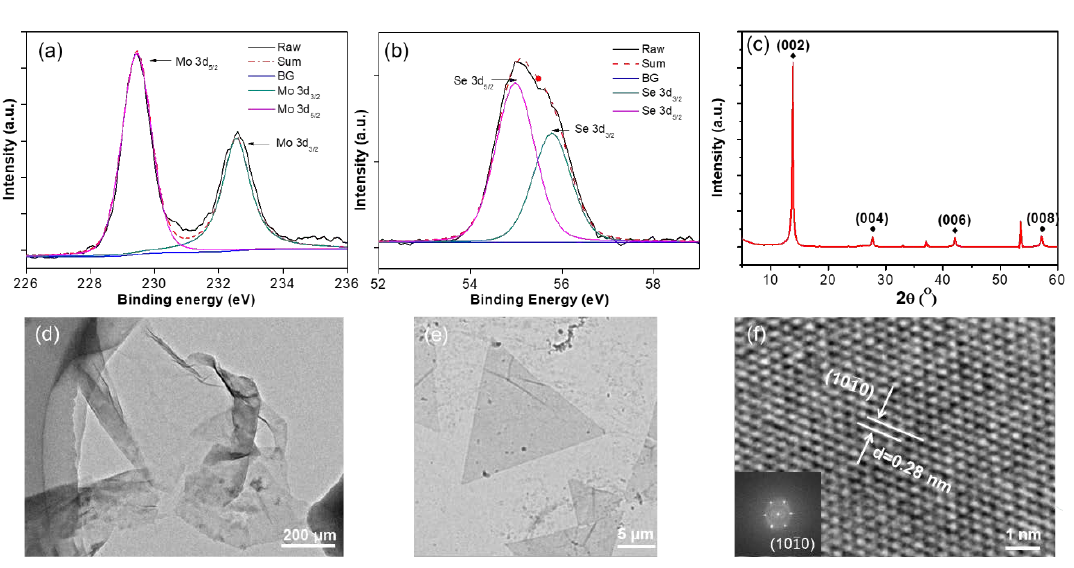
Figure 4. The X-ray photoemission spectroscopy (XPS) spectra of the monolayer MoSe 2 film, where the ( a ) Mo 3d and ( b ) Se 3d binding energies are identified. ( c ) The X-ray diffraction instrument (XRD) spectrum of the monolayer MoSe 2 film. ( d ) transmission electron microscopy (TEM) image of the transferred monolayer MoSe 2 film and ( e ) MoSe 2 flakes. ( f ) High-resolution transmission electron microscopy (HRTEM) image shows the lattice structure of the monolayer MoSe 2 film with its corresponding fast Fourier transformation (FFT) pattern (inset).